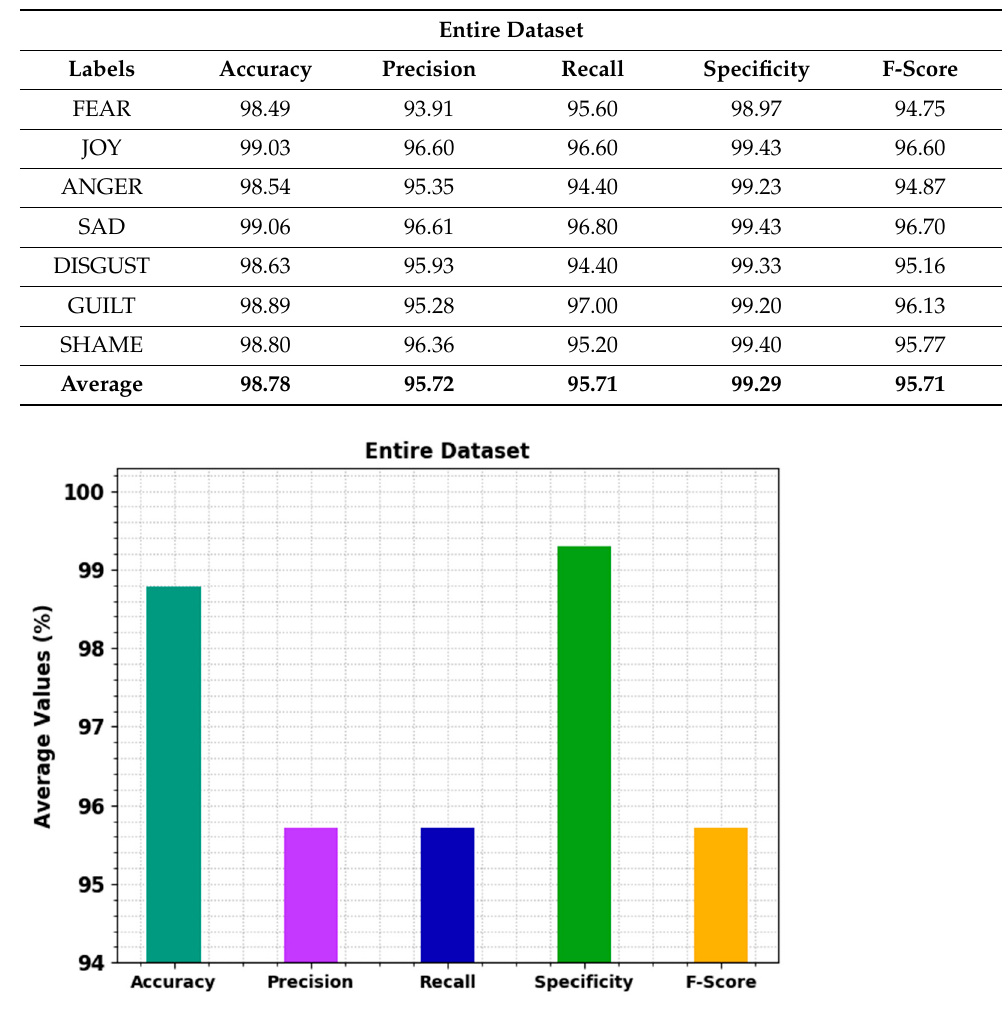
Figure 4. Result analysis of CLBEDC-SND approach under entire dataset.